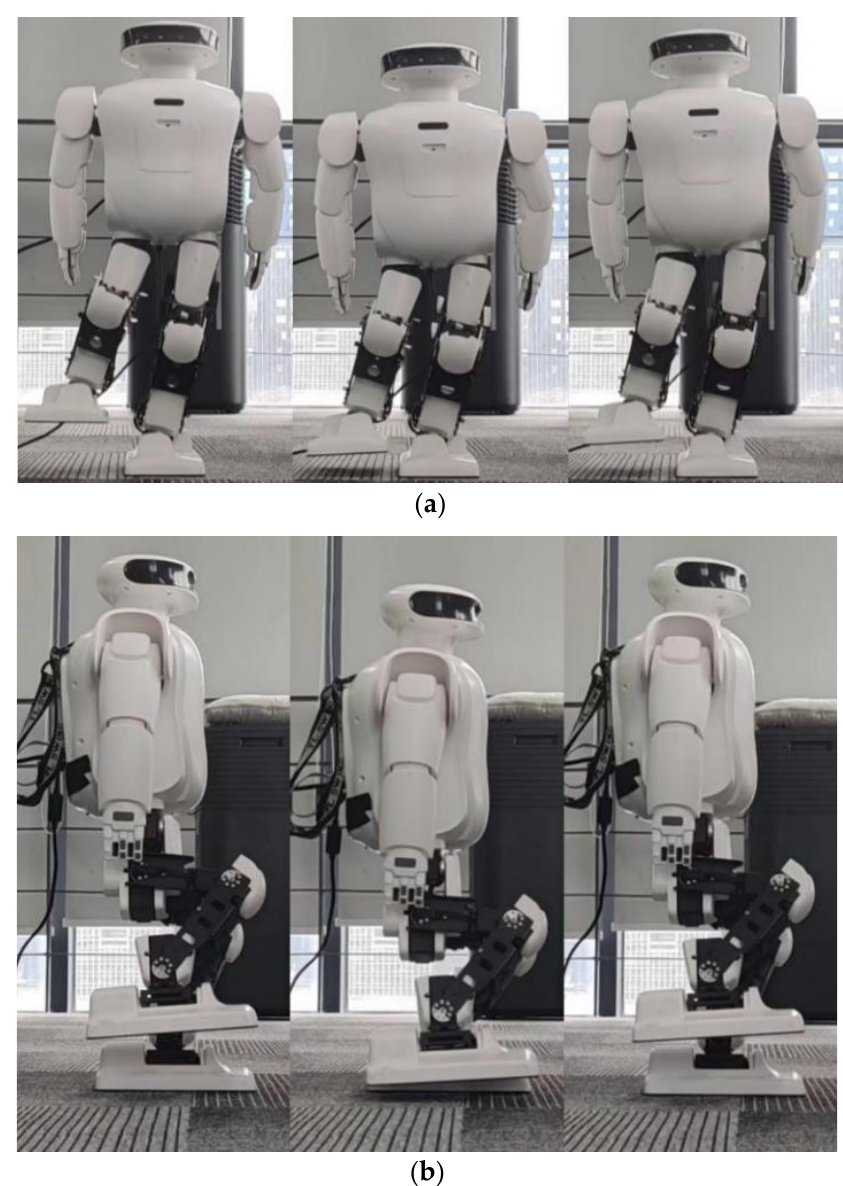
Figure 20. When Roban’s COM moves 5 cm, it completes three squats on a single leg at twice the speed using spring compensation. ( a ) A main view of the robot squatting process at twice the speed using spring compensation. ( b ) A side view of the robot squatting process at twice the speed using spring compensa-tion.